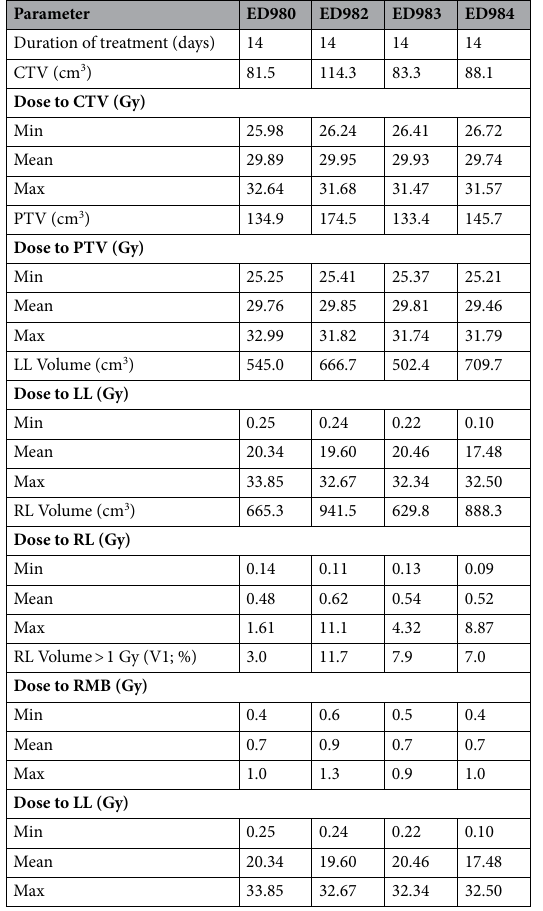
Table 1. Radiotherapy planned dose parameters for the clinical target volume (CTV), planning target volume (PTV), right lung (RL), left lung (LL), and right mainstem bronchus (RMB) of sheep prescribed 30 Gy irradiation with 6MV photons to the PTV within the caudal